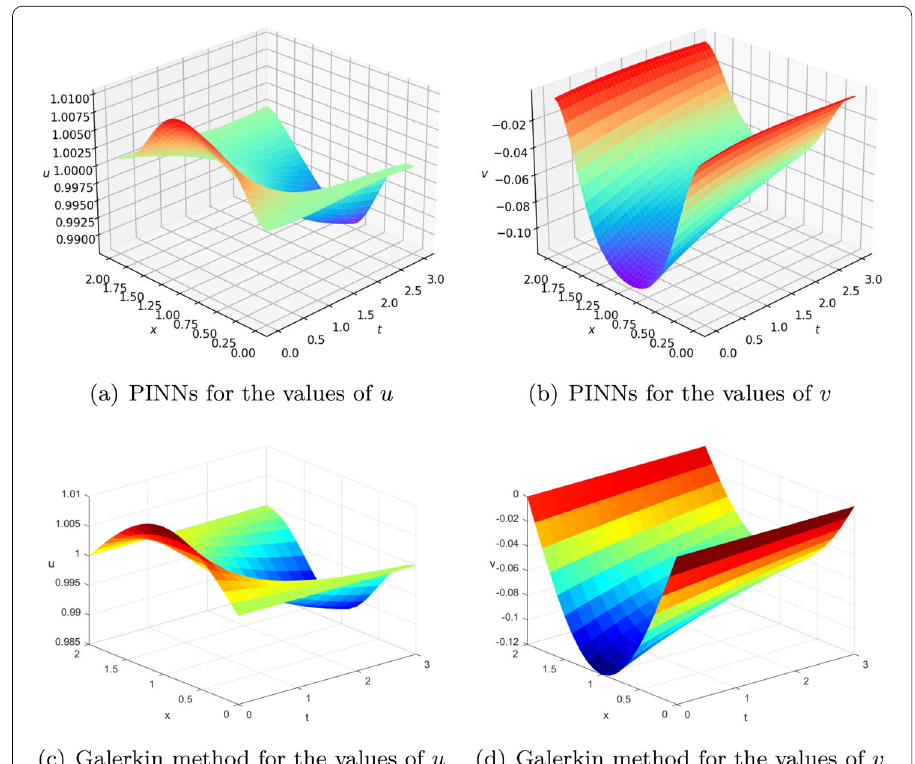
Fig. 5 Profiles of Eq(3) where D u = D v = 0 . 01, F = 0 . 09 and K = − 0 . 004 e . The results in figure (a) and (b) were implemented with PINNs. The results in figure (c) and (d) were implemented with Galerkin method